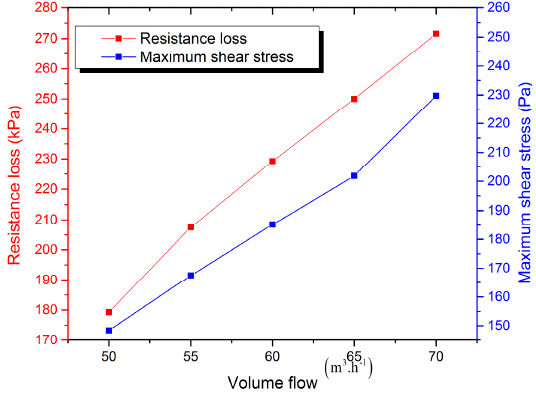
Figure 9. Influence of flow rate on resistance and shear stress.